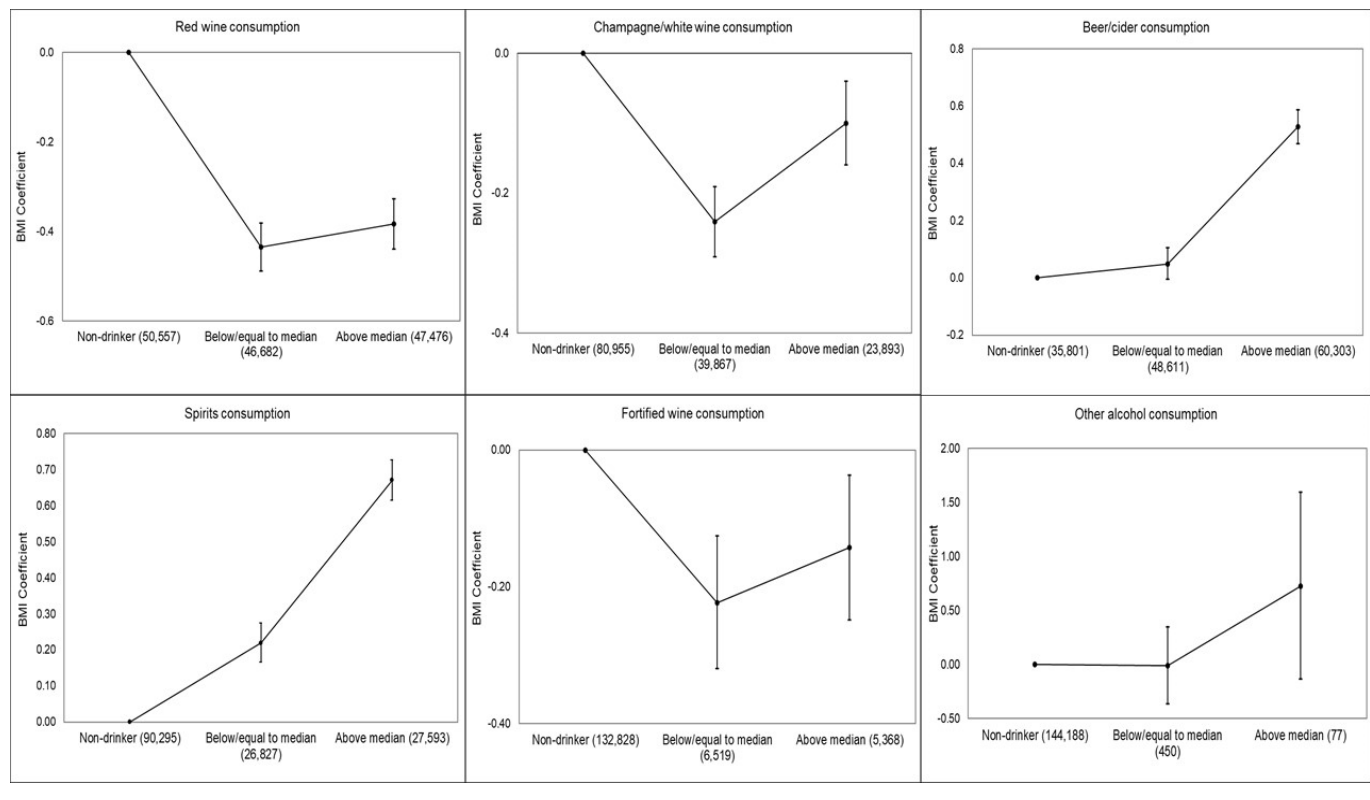
Figure 1. ( A – C ) Multivariable-adjusted dose–response association of alcoholic beverage types and BMI in the UK Biobank. The BMI coe ffi cient displays the mean di ff erence between the reference category (no consumption in last week) and the other consumption categories. The model is adjusted for age, sex, overall alcohol consumption, smoking status, sleep (h / night), sedentary behavior (h / day), illness (major cardiovascular disease or cancer), physical activity, Townsend deprivation index and daily fruit and vegetable consumption for the total sample. The model is adjusted for age, overall alcohol consumption, smoking status, sleep (h / night), sedentary behavior (h / day), illness (major cardiovascular disease or cancer), physical activity, Townsend deprivation index and daily fruit and vegetable consumption for each sex. Individuals who did not report consumption of the alcoholic beverage type in the week prior to measurement were considered non-drinkers. Low consumption was defined as less than or equal to the median for the alcoholic beverage type, and high consumption was defined as greater than the median for the alcoholic beverage type. The number of participants in each alcohol consumption category (i.e., non-drinker, low or high) included in the analysis is shown below each